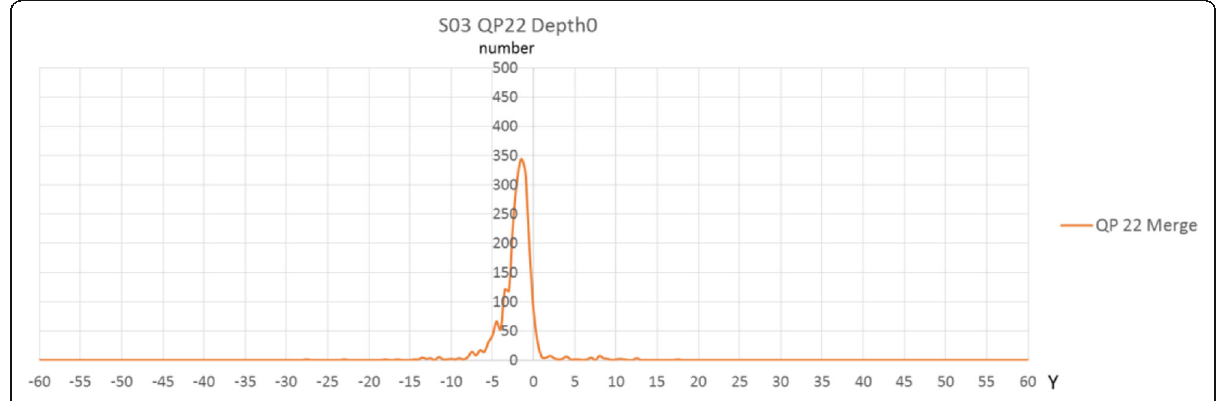
Fig. 11 The distribution of vertical component for backward prediction ( V Y _ L 1 ) for the S03